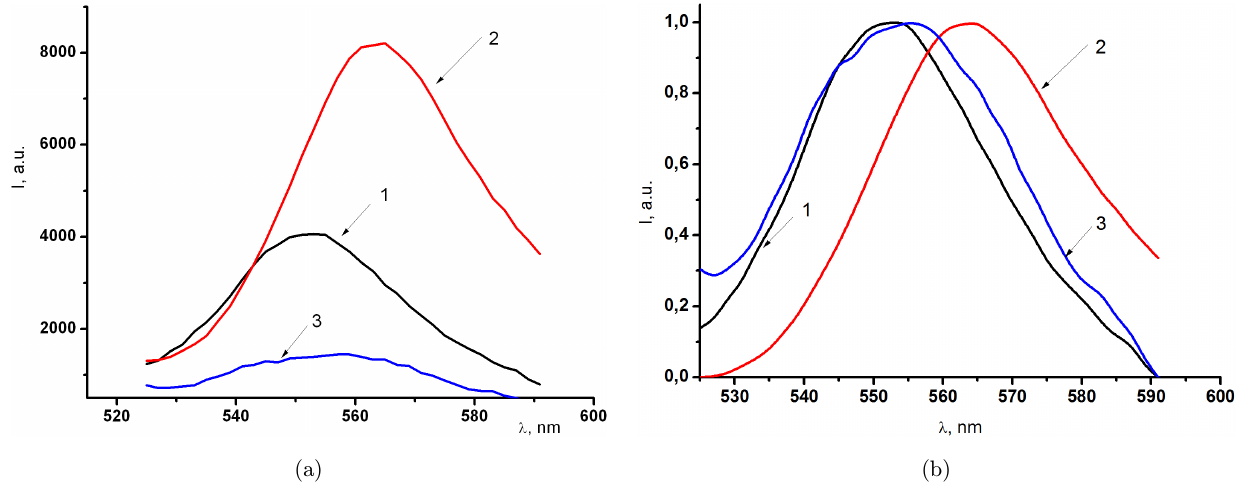
Fig. 1. Fluorescence spectra of bengal rose in: 1 — bu®er solution, 2 — in blood serum albumin, 3 — cancer mammary cells suspension, (a) native spectra and (b) normalized